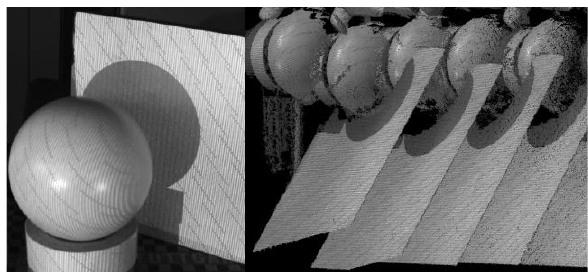
Figure 5: Image of evaluation scene and resulting point clouds for several distances Since only the precision in object space with respect to intersection angle and image scale shall be evaluated, a best-fit plane and a best-fit sphere were estimated for the 7 point clouds. Thereby, the impact of transformation uncertainties to reference data can be avoided. The fitting of the sphere and the plane, as well as the visualization of differences was performed using the software GOM Inspect. Outlier points with a residual larger than were not considered. Thus, only local noise on the surface is estimated, while neglecting outliers as occurring due to missing redundancy of multiple stereo